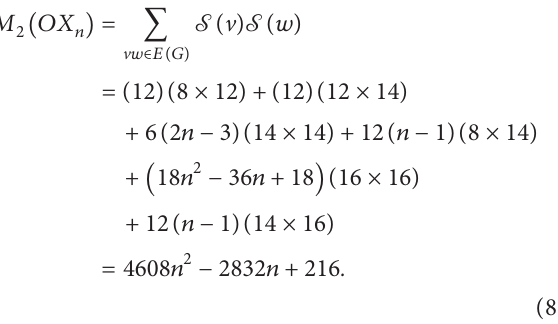
Table 1: Edge partitions of OX